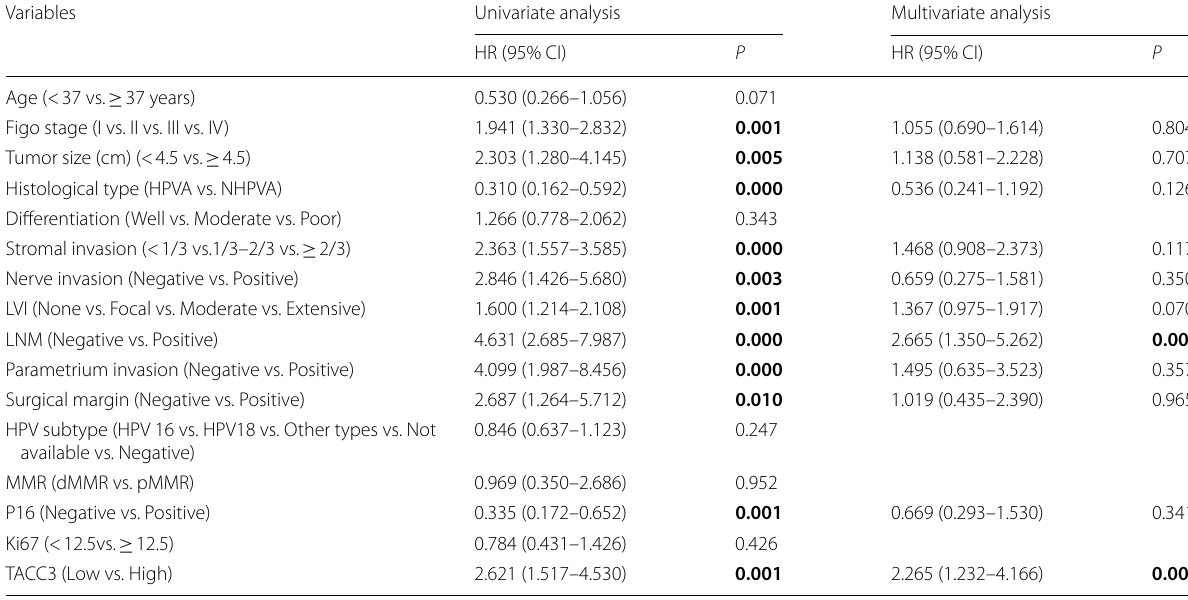
Table 3 Univariate and multivariate analyses of clinicopathological parameters and TACC3 expression for Disease‑free